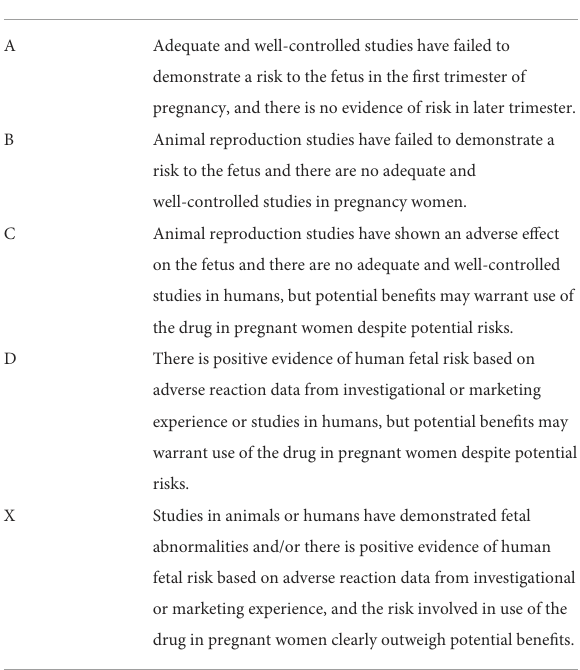
TABLE 2 United States of America food and drug administration (FDA) pharmaceutical categories in